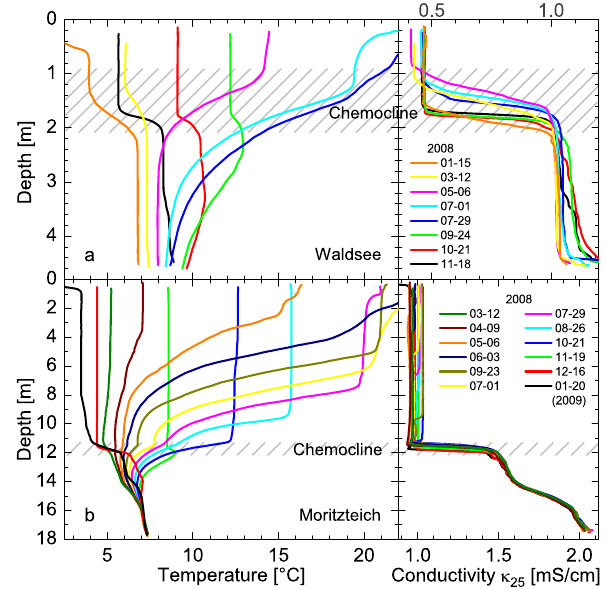
Fig. 2. Selected profiles of temperature and electrical conductivity (corrected to 25 ◦ C) of (a) Lake Waldsee and (b) Lake Moritzteich, illustrating typical seasonal